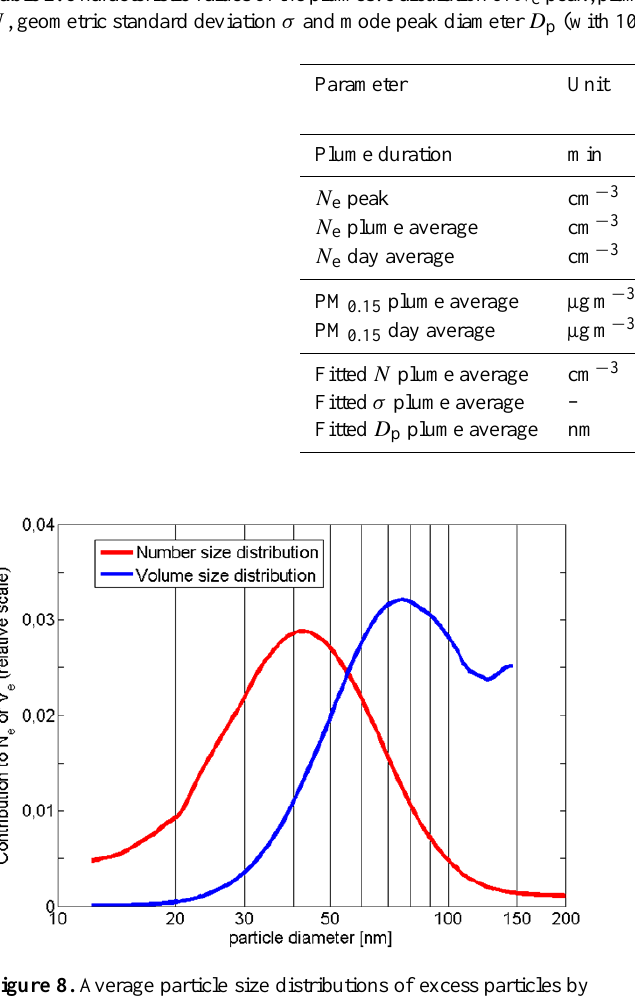
Figure 8. Average particle size distributions of excess particles by number (PNSD e ) and volume (PVSD e ) between 10 and 200nm in